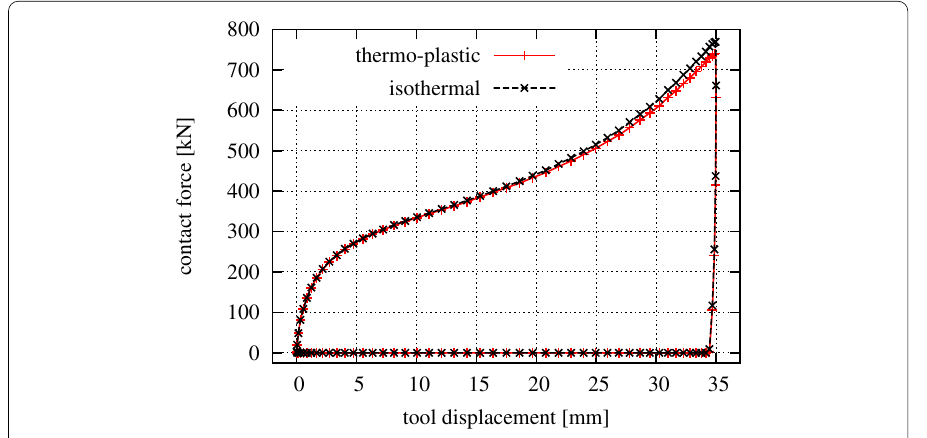
Fig. 12 Squeezed elasto-plastic tube—contact force over tool displacement for isothermal and coupled thermo-mechanical analysis